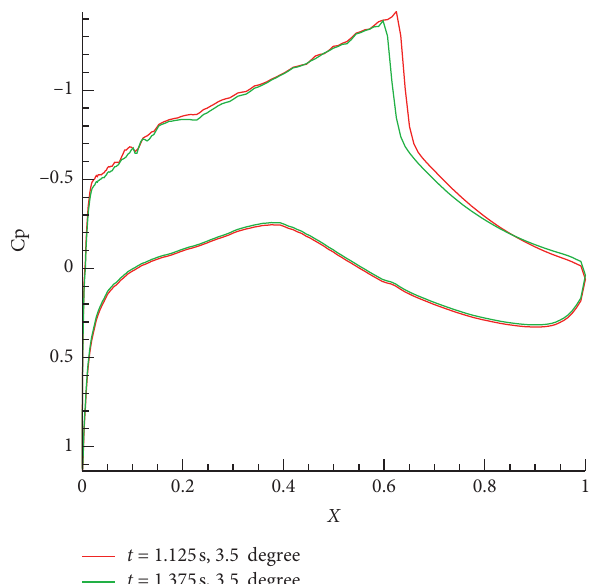
Figure 16: Pressure distribution passing through the same camber position in one cycle ( M � 0.74, α � 2 ° , and θ � 3.5 ° ,